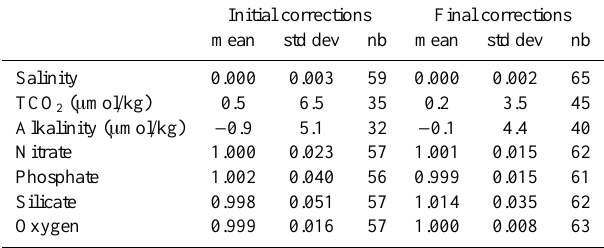
Table 4. Statistics for the global Southern Ocean: mean and standard deviation of the corrections proposed by the inversion (WDLSQ) before and after adjustment of the data and the number of cruises evaluated by the inversion.